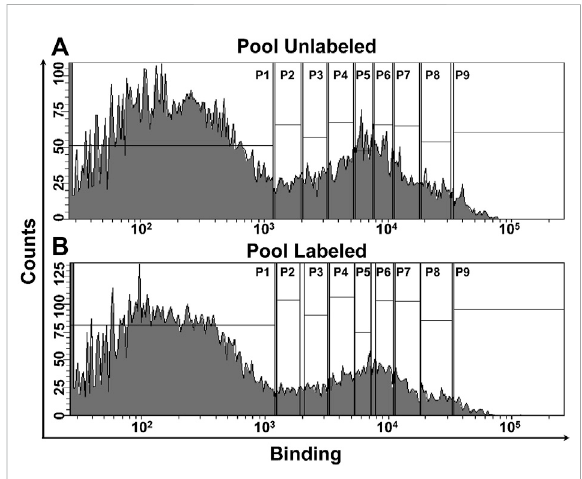
FIGURE 3 FACSofMazEandMazFlibraries.Theunlabeledlibrarieswere incubated with the cognate partner (MazF3-200 nM, MazE3- 200 nM; MazF6-375 pM, MazE6- 600 pM; MazF9-10 nM, MazE9- 200 nM). In the case of labeled libraries, the cells expressing cysteine mutants were incubated with 5 mM of labeling reagent, followed by binding with cognate partner at identical concentration used for the unlabeled library. (A,B) FACS of the six pooledMazFandMazElibraries.Histogramshowingbindingofthe (A) unlabeled and (B) labeledlibraries. Thevertical gateswereused to sort different populations based on the binding pro fi les as described (Ahmed et al., 2022a). Deep sequencing was used to reconstruct the binding MFI of individual members in the unlabeled and labeled libraries (Ahmed et al.,